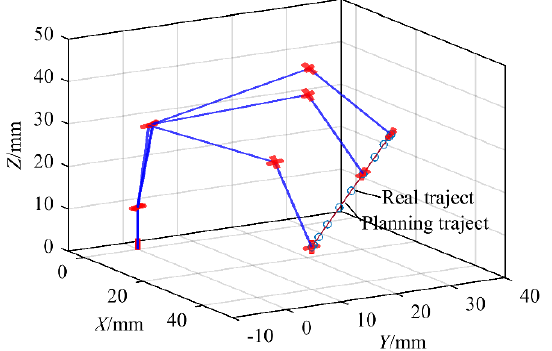
Figure 10. The comparison of planned trajectory and actual trajectory.